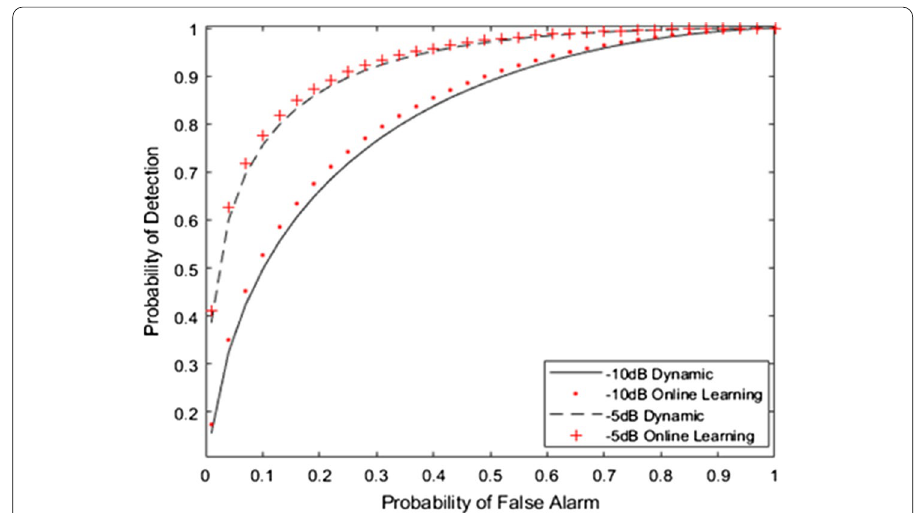
Fig. 9 ROC ( P d vs P fa ) of matched filter detection sensing under AWGN channel